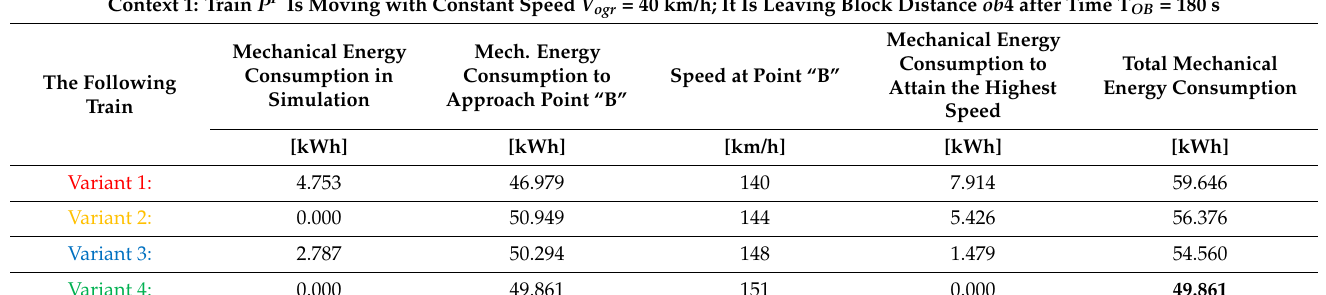
Table 3. Standardization of results for context 1.